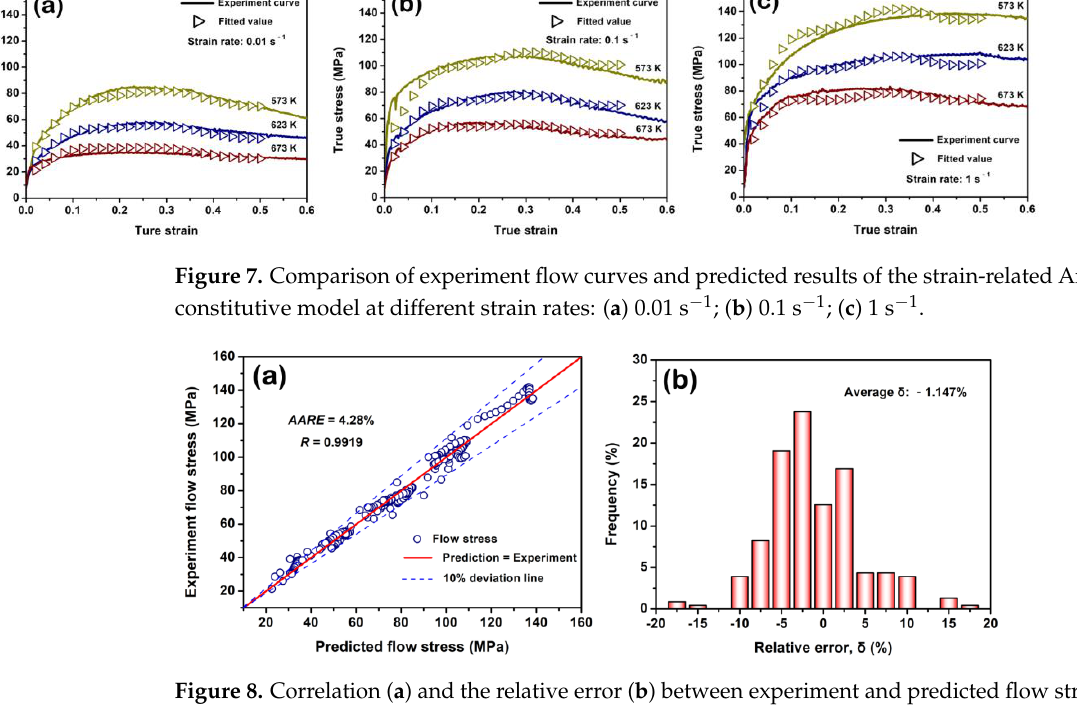
Figure 8. Correlation ( a ) and the relative error ( b ) between experiment and predicted flow stresses by the strain-related Arrhenius constitutive model.